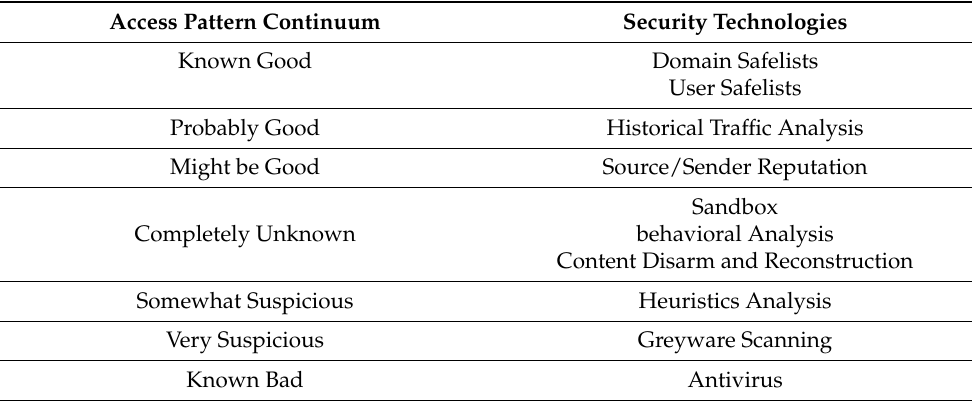
Table 1. Access pattern continuum